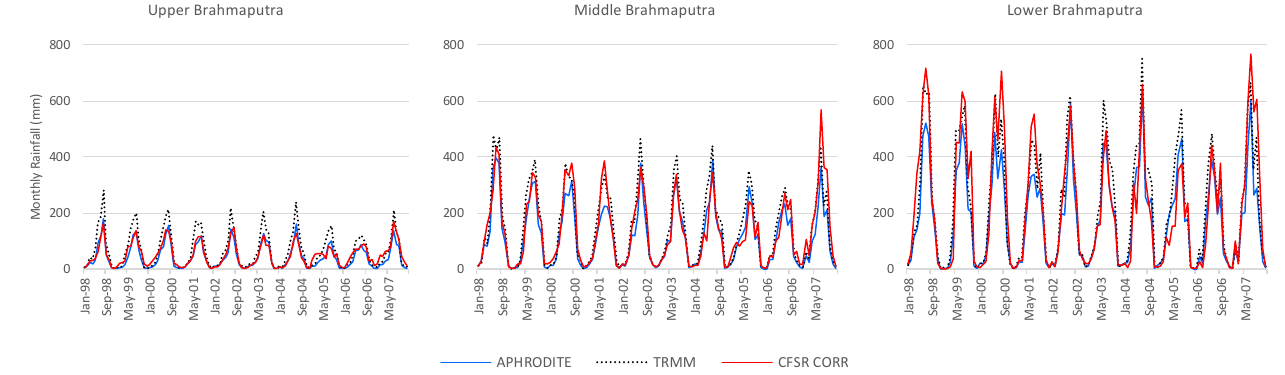
Figure 5. Comparison of CFSR rainfall with APHRODITE and TRMM data on monthly and regional